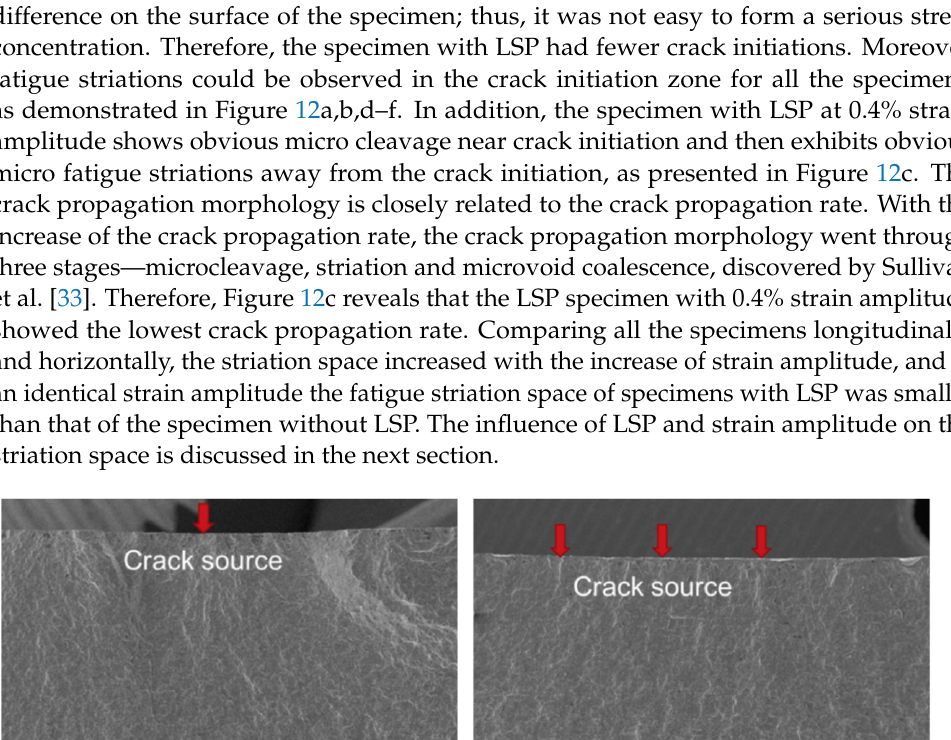
Figure 11. SEM micrographs revealing crack sources for specimens ( a ) with LSP and ( b ) without LSP.